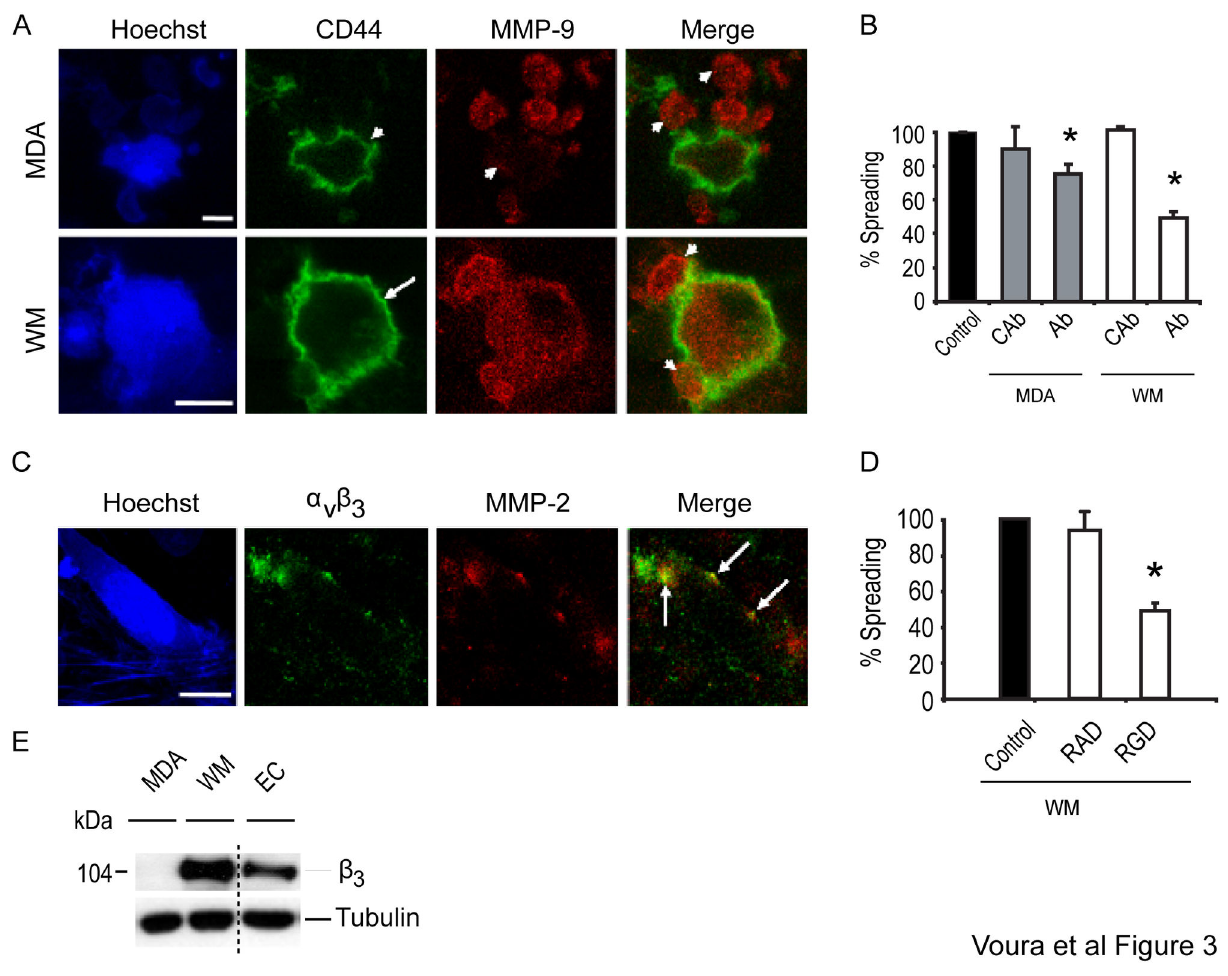
Figure 3. The association of cell adhesion molecules and MMPs during tumor cell transendothelial migration. (A) Blue cell tracker and Hoechst labeled tumor cells (bright blue cells and nuclei) incubated on EC for 3 hours. Both tumor and EC were stained for actin (pale blue). 1 μm sections through a seeking MDA-MB231 cell (upper panel) and a seeking WM239 cell (lower panel) labeled for CD44 (green) and MMP-9 (red) are shown. Arrowhead and arrow point to CD44 in heterotypic tumor cell-endothelial cell contacts or on the cell surface, respectively. Arrowheads also indicate little cell surface, or abundant MMP-9 staining of blebs (merged images). Note that the blebs also show circumferential actin staining in blue. Bars=10 μm. (B) Inhibitory MMP-9 mAb (Ab; 15 μg/mL) used to block MDA-MB231 (gray bars) and WM239 (white bars) extravasation. (C) 1 μm confocal sections of a blue cell tracker and Hoechst labeled WM 239 cell (bright blue cells and nuclei) incubated on EC for 3 hours and undergoing the spreading stage of transendothelial migration. Experiments were subjected to labeling of actin in both tumor and EC cells (pale blue). Labeling of α β (green) and MMP-2 (red). Arrows indicate spectral co-localization (yellow) in merged image. Bars=10 μm. (D) An α v 3 specific blocking cyclic peptide (RGD; 90 μM) reduced WM239 melanoma extravasation compared with a non-blocking cyclic RAD peptide (RAD; 90 μM) as shown in the white bars. The black bar is the relative control with no peptide. (E) Western blot of total cell lysates from MDA-MB231 (MDA), WM239 (WM) and EC cultured in EC media with TNFα (10 ng/mL) show the expression of the β integrin subunit. Tubulin is a protein loading control. The dotted line represents an excised lane.